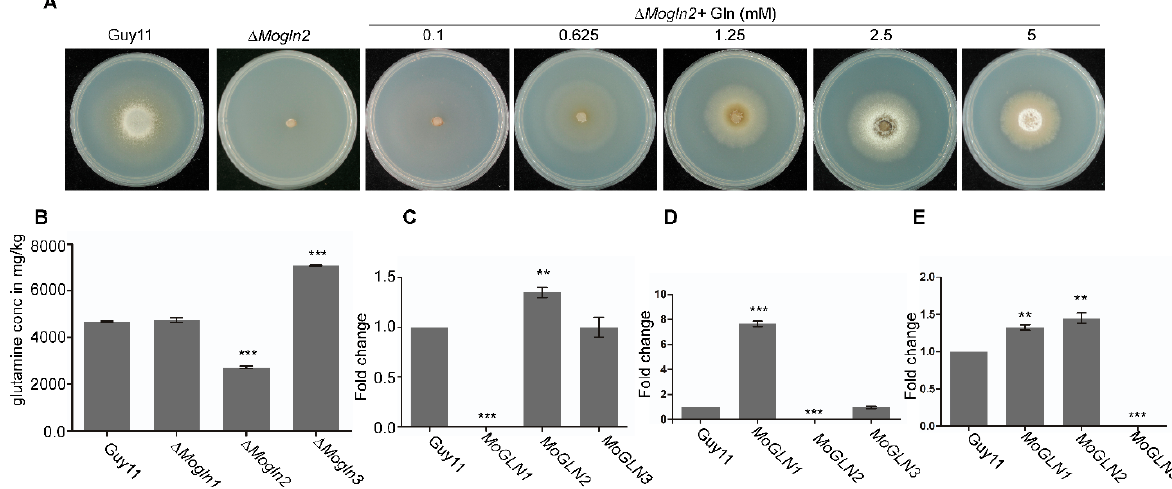
Figure 5. Exogenous glutamine restores growth defects of Δ Mogln2 on MM medium. ( A ) Radial growth of Δ Mogln2 mutant on MM medium supplemented with different concentrations of glutamine. The experiment was repeated three times with similar results obtained. ( B ) Statistical representation of intracellular glutamine levels detected in WT and the three MoGLN mutants. Error bars represent standard deviations obtained from two independent tests. Data were analyzed using GraphPad Prism 8; asterisks indicate statistically significant differences (**, p < 0.01; ***, p < 0.001; based on one-way ANOVA with Tukey’s multiple-comparison test). ( C ) Graph showing the expression of MoGLN2 and MoGLN3 in Δ Mogln1 mutant; ( D ) graphical representation of expression pattern of MoGLN1 and MoGLN3 in the Δ Mogln2 mutant; ( E ) expression pattern of MoGLN1 and MoGLN2 in Δ Mogln3 mutant. The actin gene was used as a control. Data for statistical analysis were obtained after performing three independent biological replicates. Error bars represent standard deviations. Asterisks indicate statistically significant differences (**, p < 0.01; ***, p < 0.001; one-way ANOVA was used to analyze data with Tukey’s multiple-comparison test in GraphPadPrism 8).